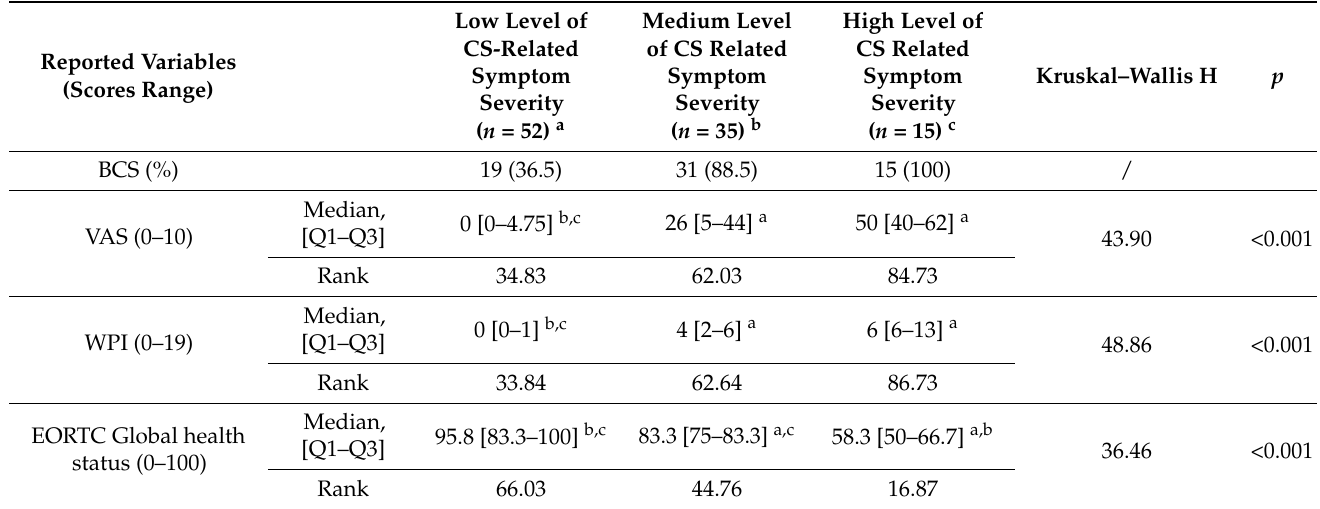
Table 4. Participant-reported clinical variables by CSI